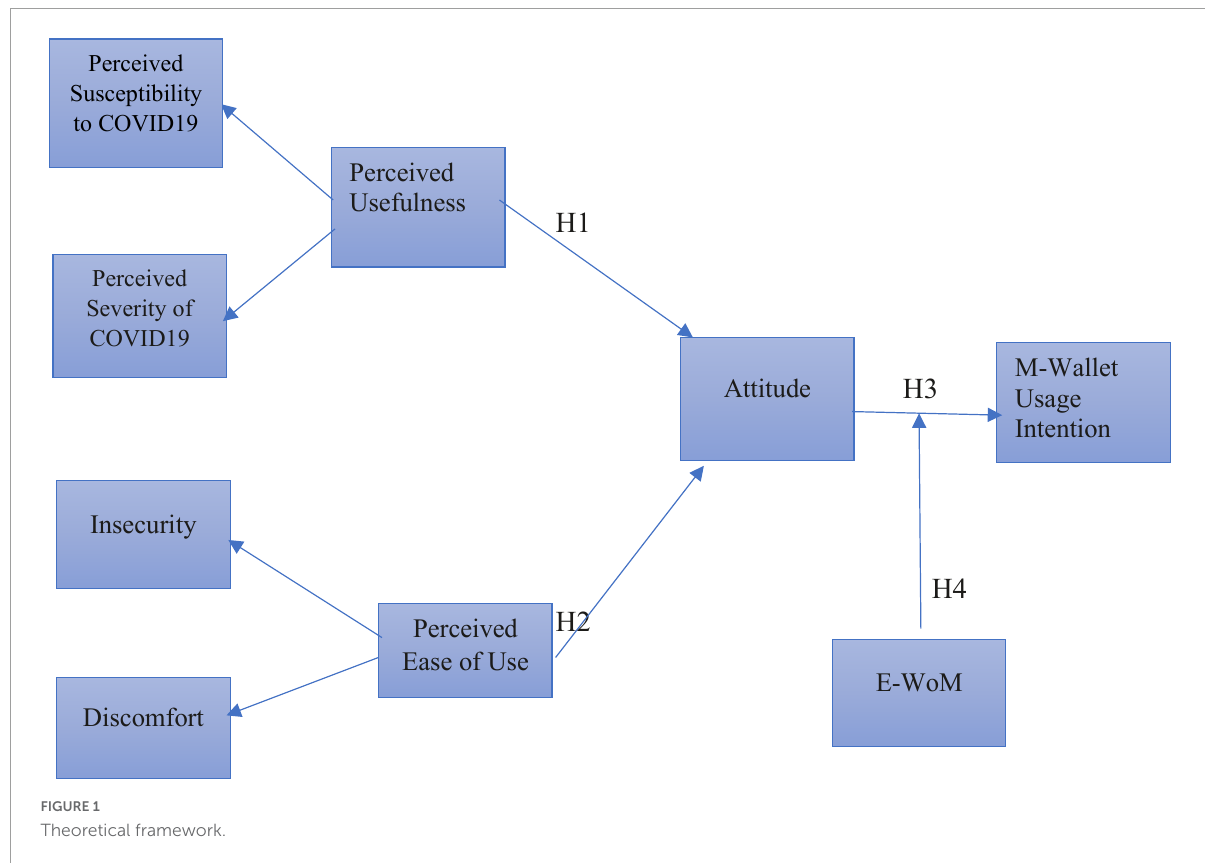
FIGURE1 Theoretical